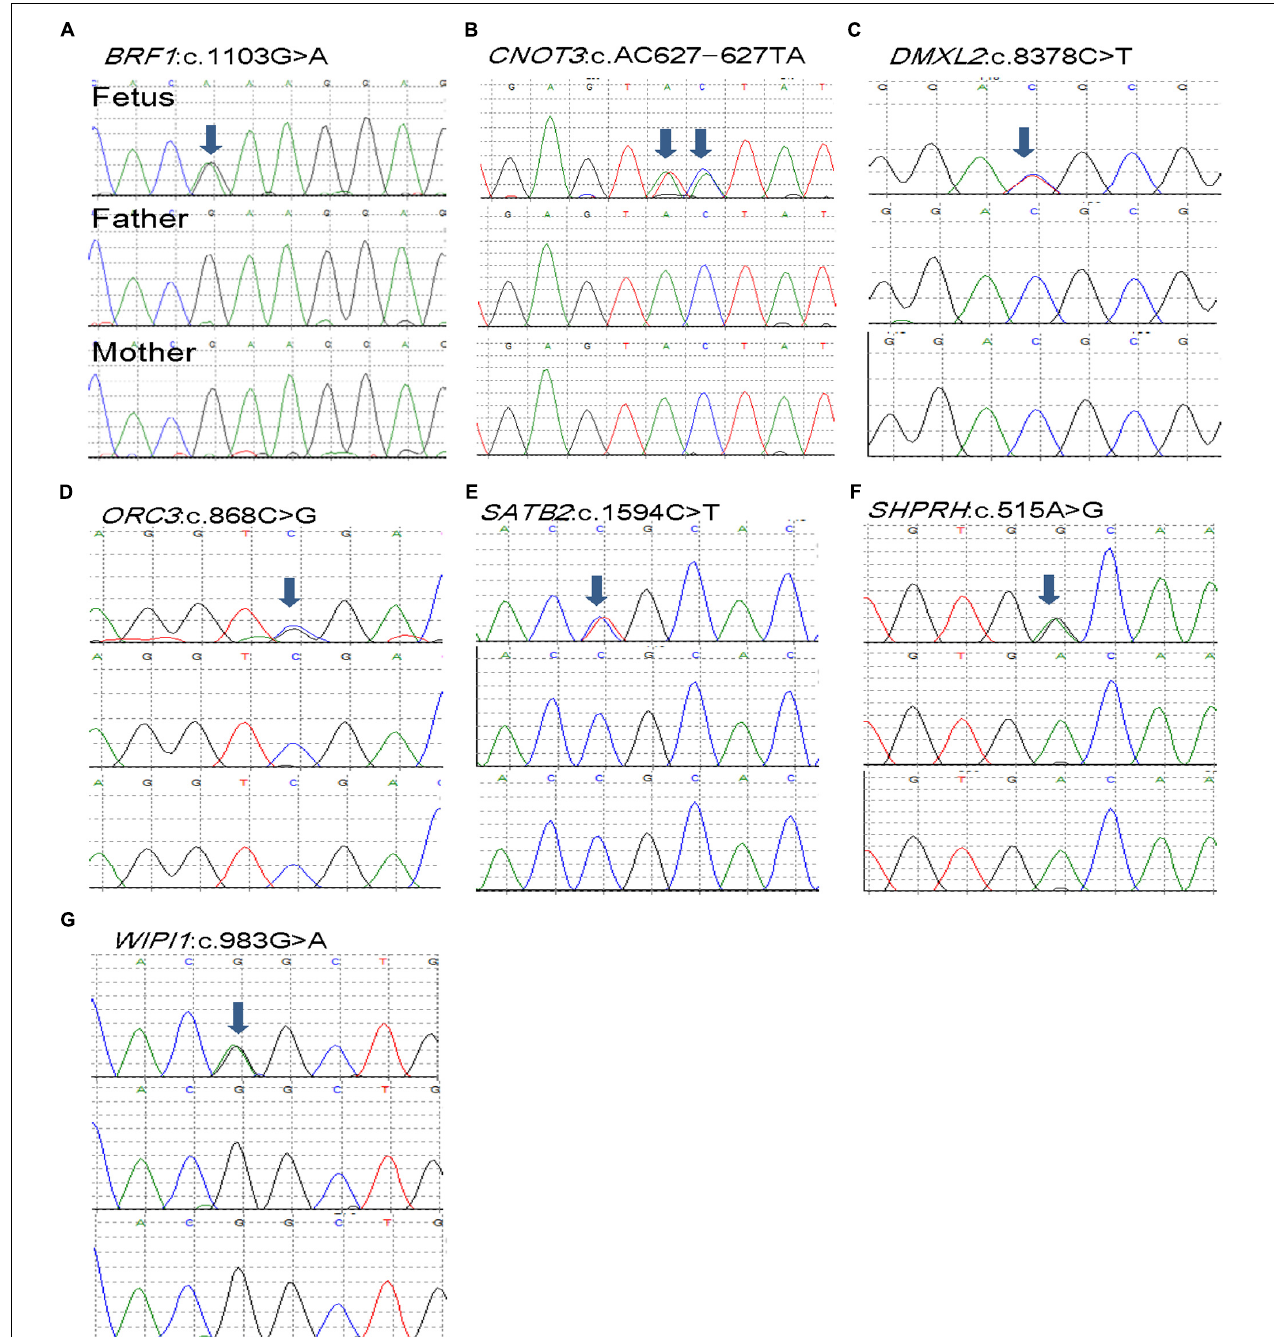
FIGURE 1 | De novo mutations (DNMs) validation of selected seven DNVs in trios affected with anencephaly. Chromatograms of the three individuals from one trio (from top to bottom: fetus, father, and mother). (A) BRF1 de novo variant. (B) CNOT3 de novo variant. (C) DMXL2 de novo variant. (D) ORC3 de novo variant. (E) SATB2 de novo variant. (F) SHPRH de novo variant. (G) WIPI1 de novo variant.